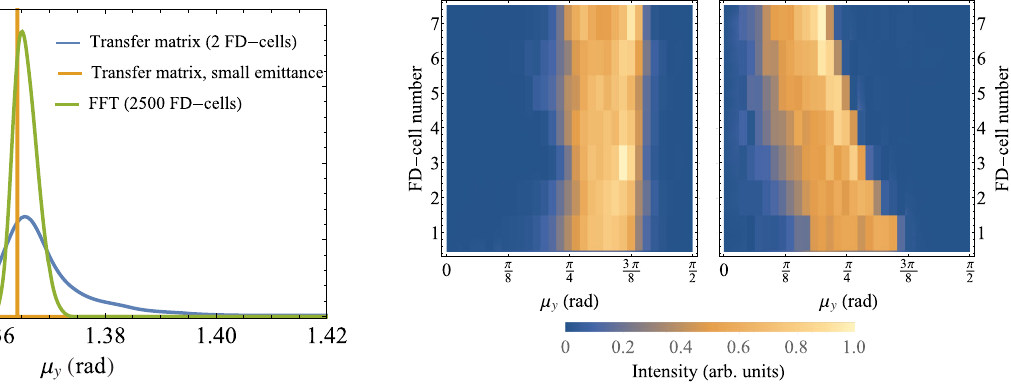
FIG. 11. Transverse phase advance for a negligible emittance in complete agreement with the analytical μ y ¼ 1 . 3642 and a distribution with 20 nm bunch length and 100 nm transverse size. The latter is obtained by both FFT and the transfer matrix reconstruction method. The narrowing of the FFT curve origi- nates from high amplitude particle losses over the long (2500 cells) transport distance.